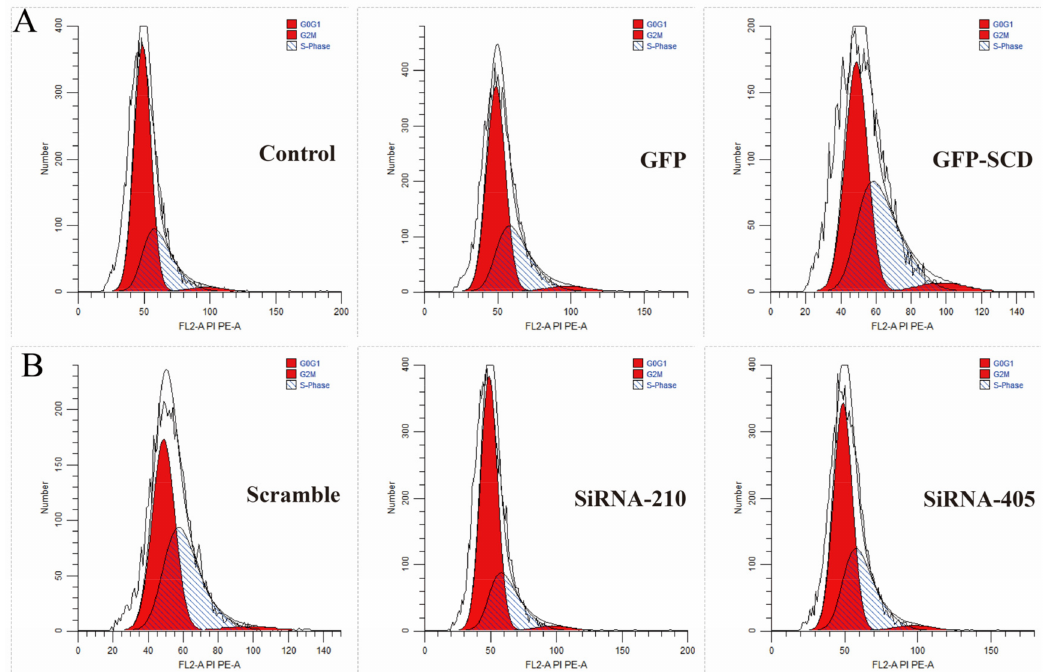
Figure 1. Effects of stearoyl-CoA desaturase ( SCD ) overexpression and SCD knockdown on the cell cycle of goose granulosa cells (GCs). ( A ) Cell cycle stages of GCs were analyzed after SCD overexpression. ( B ) GCs cell cycle stages were analyzed after SCD knockdown.